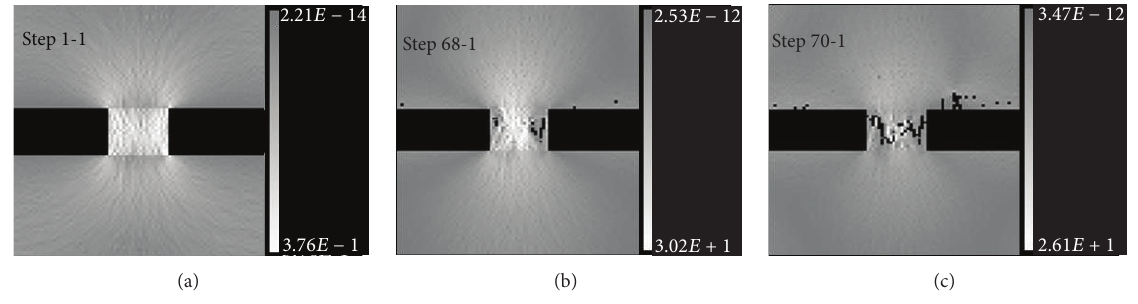
Figure 12: Plot of shear stresses around a pillar with width-to-height ratio =